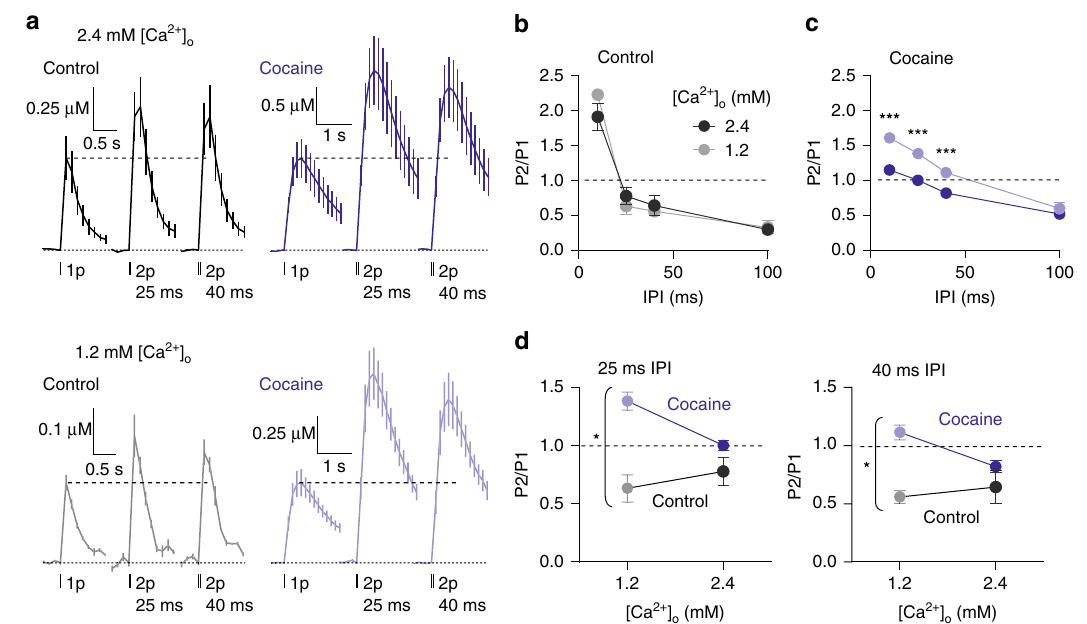
Fig. 7 DATs limits release-dependence of short-term plasticity in CPu. a Mean pro fi les of [DA] o transients (± SEM, vertical scale normalised to 1p in 2.4 mM [Ca 2 + ] o ) ( n = 4) elicited by single or paired electrical pulses in 2.4 mM (upper) and 1.2 mM [Ca 2 + ] o (lower) in control conditions (black) or 5 µ M cocaine (blue). b , c Mean P2/P1 vs IPI in 1.2 mM (light) and 2.4 mM [Ca 2 + ] o (dark) in control conditions ( b ) or cocaine ( c ). d Mean P2/P1 in 1.2 mM and 2.4 mM [Ca 2 + ] o in control conditions (black-grey) or cocaine (blue) at 25 ms IPI (left) or 40 ms IPI (right). Two-way ANOVA with Bonferroni ’ s test for post hoc comparisons; * P < 0.05, ** P < 0.01, *** P < 0.001. Source data are provided as a Source Data fi le 4). There was a signi fi cantly stronger effect of [Ca 2 + ] o on PPR in (Fig. 7d; two-way ANOVA, cocaine × [Ca 2 + ] o interaction; F 1,12 = 7.86; P = 0.016; n = 4) and 40 ms IPI (Fig. 7d; two-way ANOVA, cocaine × [Ca 2 + ] o interaction; F 1,12 = 4.72, P = 0.050, n = 4), but